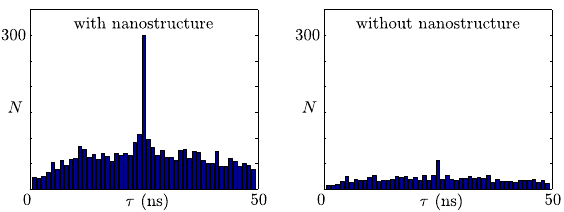
Figure 4: Coincidence peaks. Coincidence peaks obtained after one photon of the entangled pair is transferred through either the HPPS at normal incidence (left) or a flat gold film (right). Table 1: Summary of results. We quote the loss of each sample (measured with classical light), the rate of coincident detection for entangled photons (when phase modulation is off), and the visibility V of the two-photon interference pattern (extracted from coincidence measurements when phase modulation is on, see fig. 5 and eq. 4). In the case of a flat gold film, losses where too high to obtain reliable visibilities.